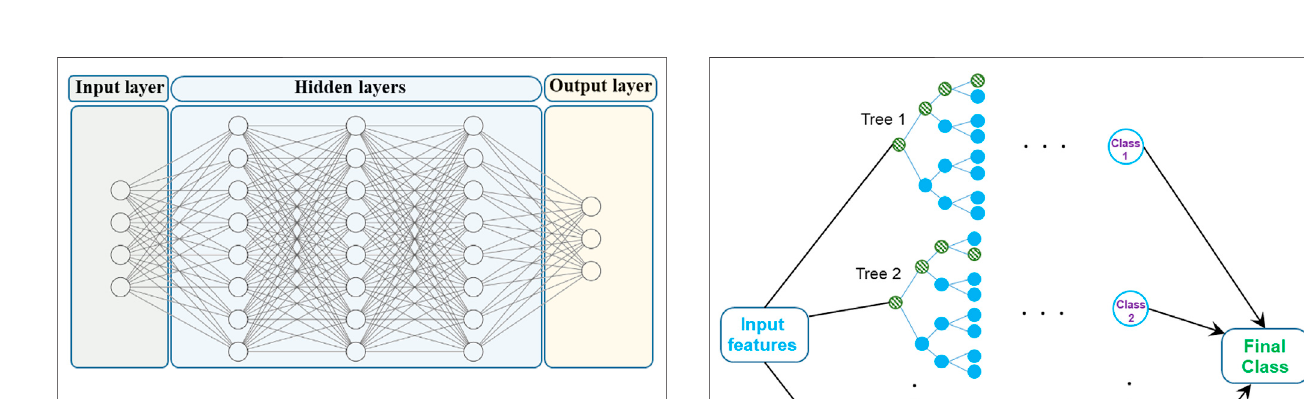
FIGURE 1 | Machine learning categories.